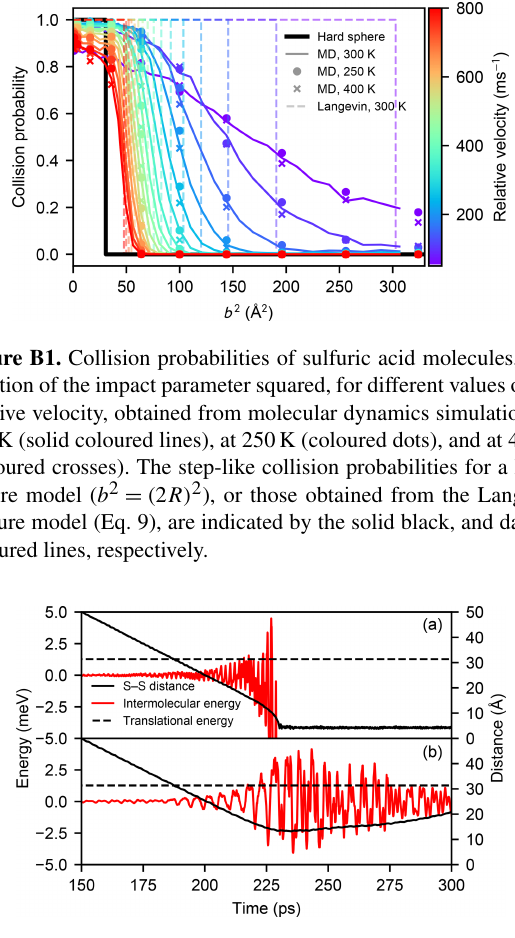
Figure C1. Time evolution of the intermolecular energy (red line) and the sulfur–sulfur distance (solid black line) in one MD tra- jectory with relative velocity v = 50ms − 1 and b = 0Å where a collision occurs (a) and one where the molecules are repelled at range (b) . The initial translational kinetic energy of the molecules (1.27meV) is indicated by the dashed black